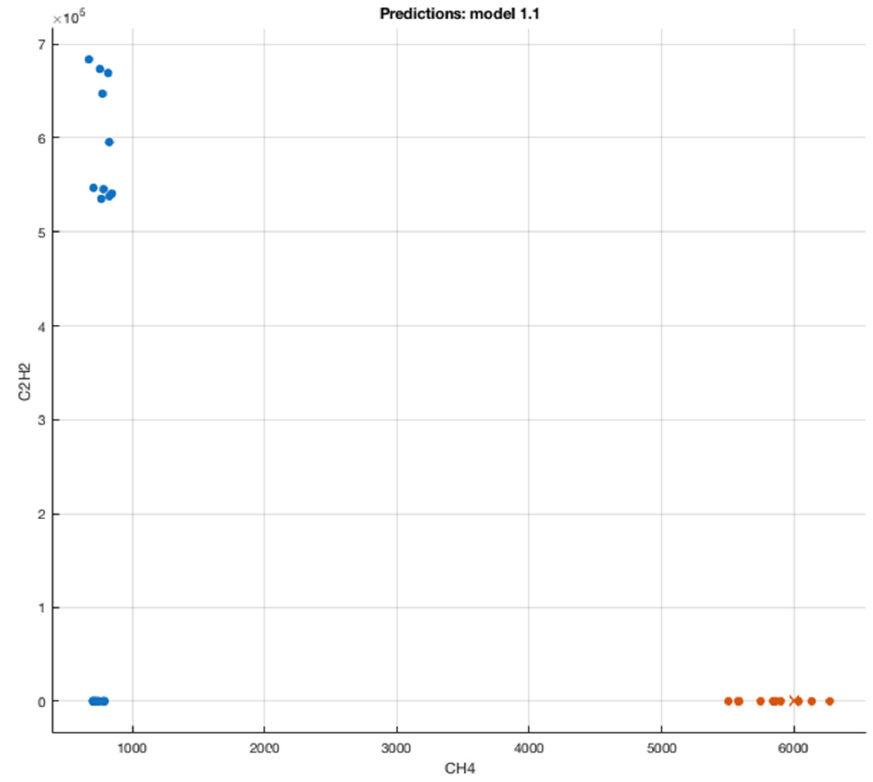
Figure 9. CH (cid:2872) versus C (cid:2870) H (cid:2870) . Blue and orange (•)—raw data, orange and blue (×)—predicted data. Figure 9. CH 4 versus C 2 H 2 . Blue and orange ( • )—raw data, orange and blue ( × )—predicted